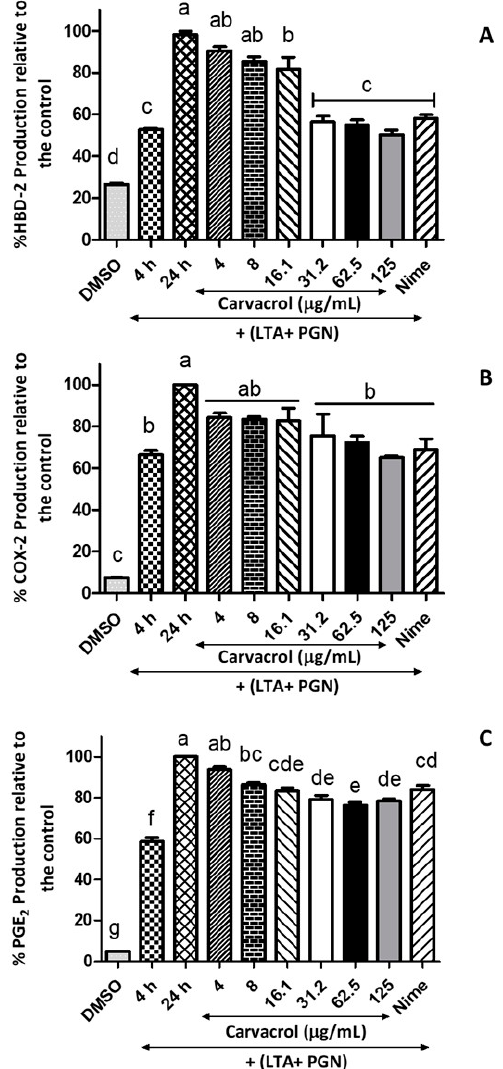
Figure 6. Inhibitory effects of carvacrol on the production of HBD-2, COX-2, and PGE 2 in LTA- and PGN-stimulated human tonsil epithelial cells; Tonsil cells were treated with carvacrol (4–125 µ g/mL) for 20 h after 4 h stimulation with an LTA and PGN mixture (5 µ g/mL, each). Supernatants were harvested 20 h after stimulation. Production of ( A ) HBD-2, ( B ) COX-2, and ( C ) PGE 2 in the culture supernatants were determined by ELISA. Results are shown as the mean ± SE. Data are representative of three independent experiments conducted in triplicate. The different letters above the columns (a–g) show that the means of different groups were significantly different ( p < 0.05) by one-way analysis of variance using Tukey’s test. HBD-2: human beta defensin-2; COX-2: cyclooxygenase 2; PGE 2 : prostaglandin E2; LTA: lipoteichoic acid; and PGN: